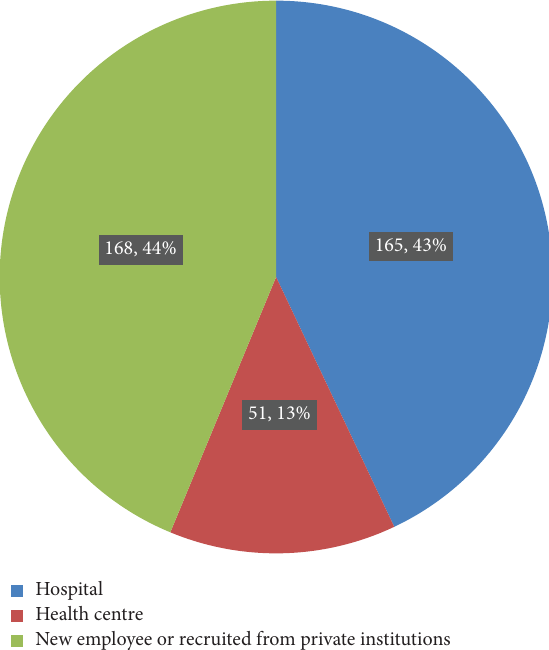
Figure 1: Previous employment facility or status of the